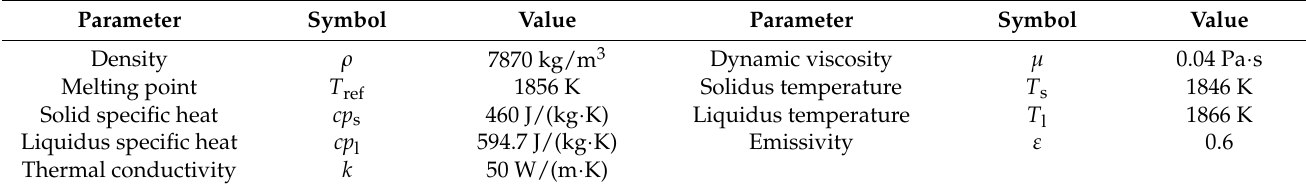
Table 2. Material properties used in the numerical simulation.